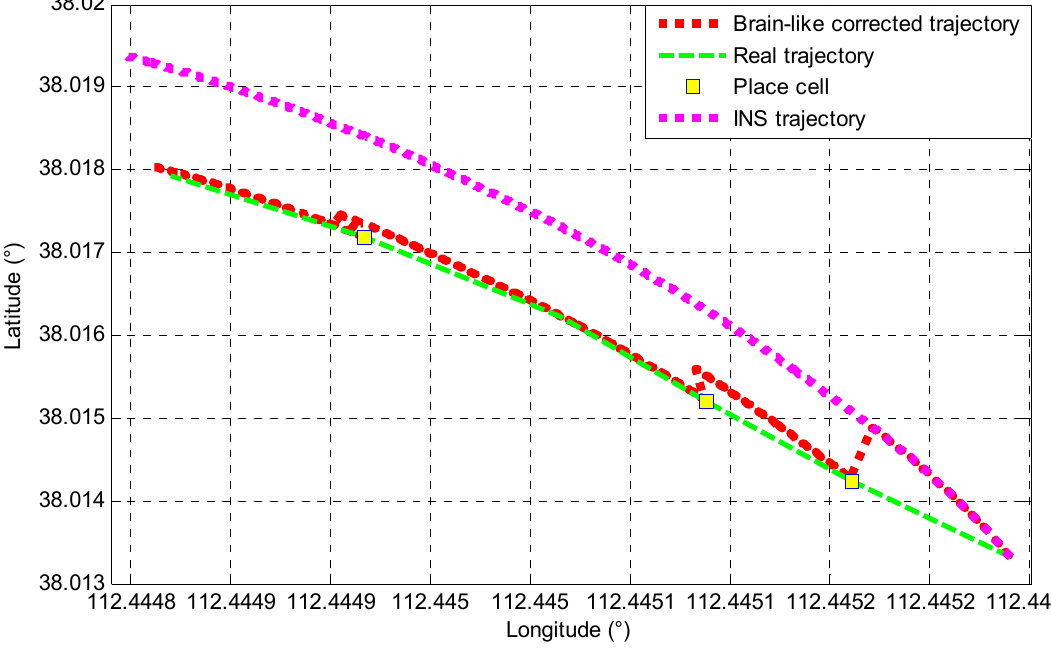
Figure 11. Place experimental results.